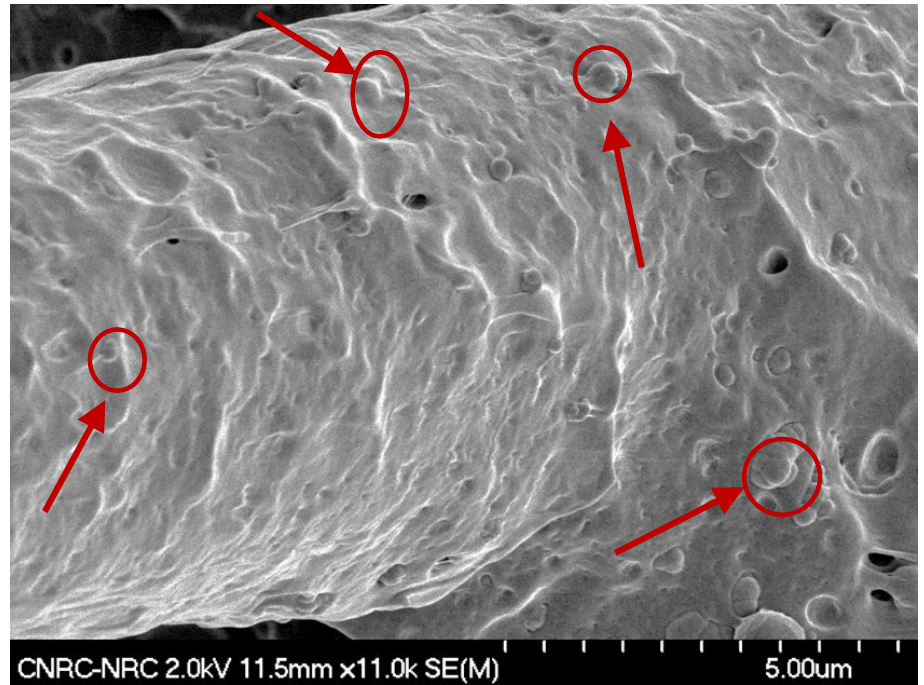
Figure 11. SEM micrograph obtained on one CF surface covered by the polymer matrix and TB N990 particles (in PP and PA6 hybrids only).